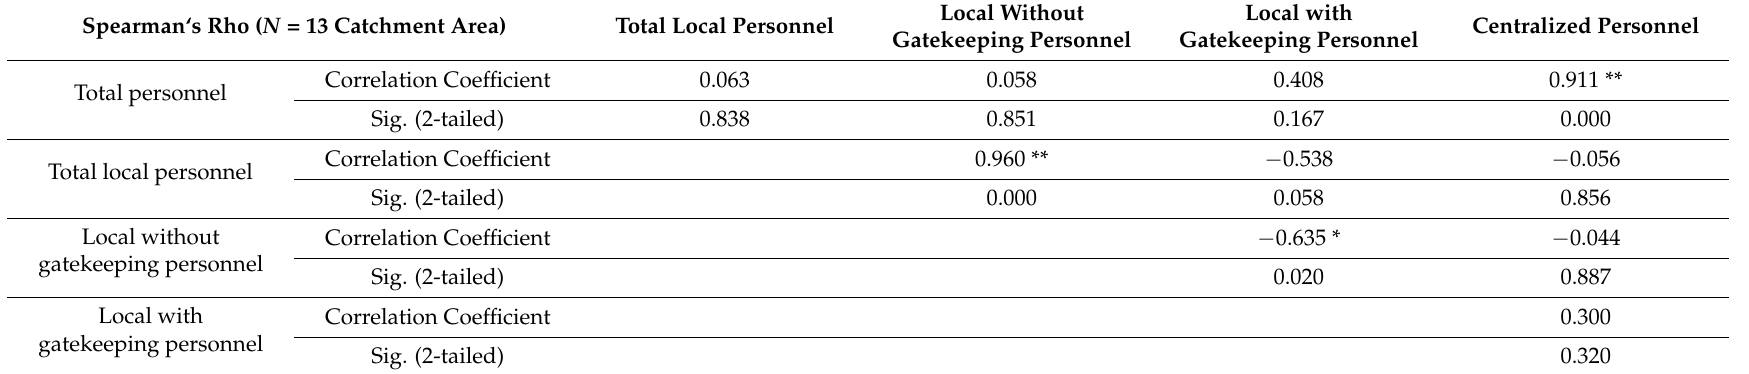
Table 3. Correlations between allocated full time equivalents per 1000 18+ in local vs centralized